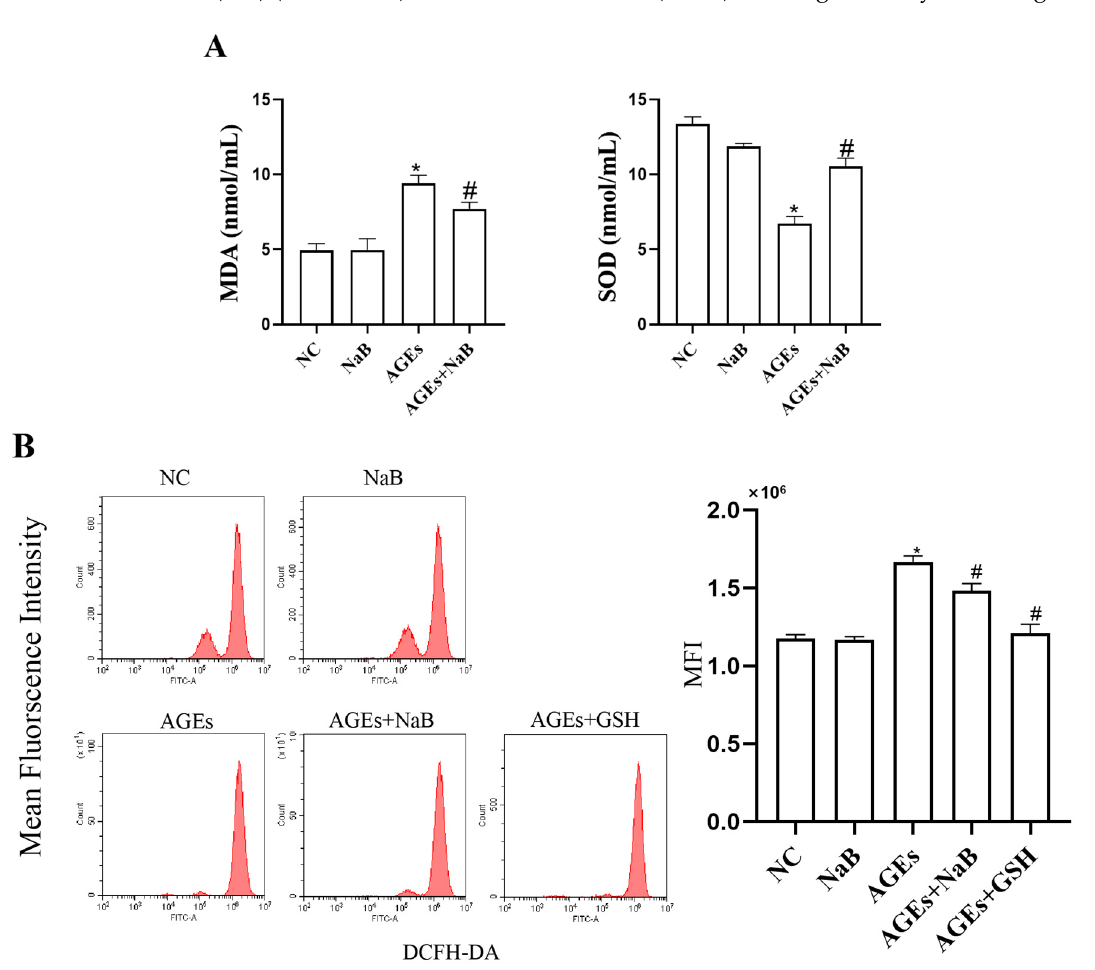
Figure 2. The oxidative stress-related ROS, MDA, and SOD level in THP-1 cells ( n = 3/group). ( A ): Intracellular MDA level and intracellular SOD level. The MDA level was determined by thibabituric acid (TBA) method. The SOD level was determined by xanthine oxidase method (hydroxylamine method). ( B ): Intracellular ROS level. The intracellular ROS level was determined by DCFH-DA fluorescent probe kit. NC: normal control; NaB: 400 μ mol/L NaB; AGEs: 400 μ g/mL AGEs; AGEs+NaB: pre-treated with 400 μ mol/L of NaB for 24 h, and then treatment with 400 μ g/mL of AGEs. *: compared with the NC group, p < 0.05; #: compared with the AGEs group, p < 0.05.